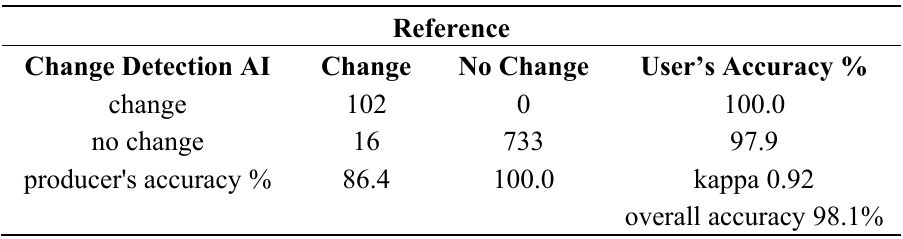
Table 4. Error matrix for the change detection results using Aerial images.